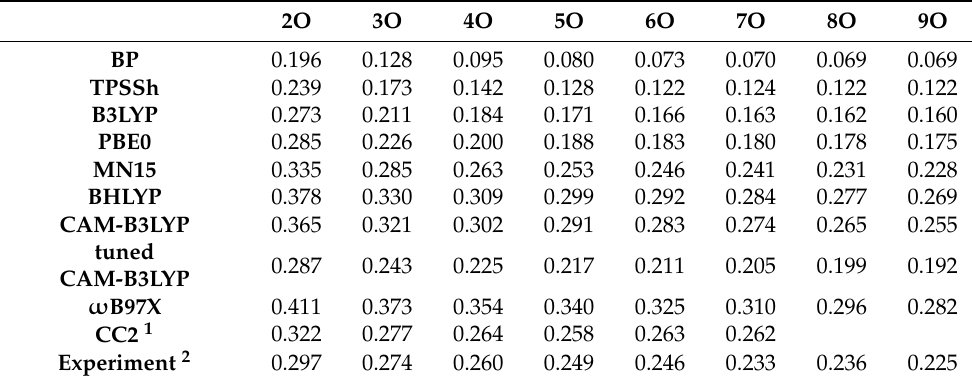
Table 3. Reorganization energies calculated for the studied oligofurans using the selected variants of DFT/TDDFT and the CC2 method with the def2-TZVPP basis